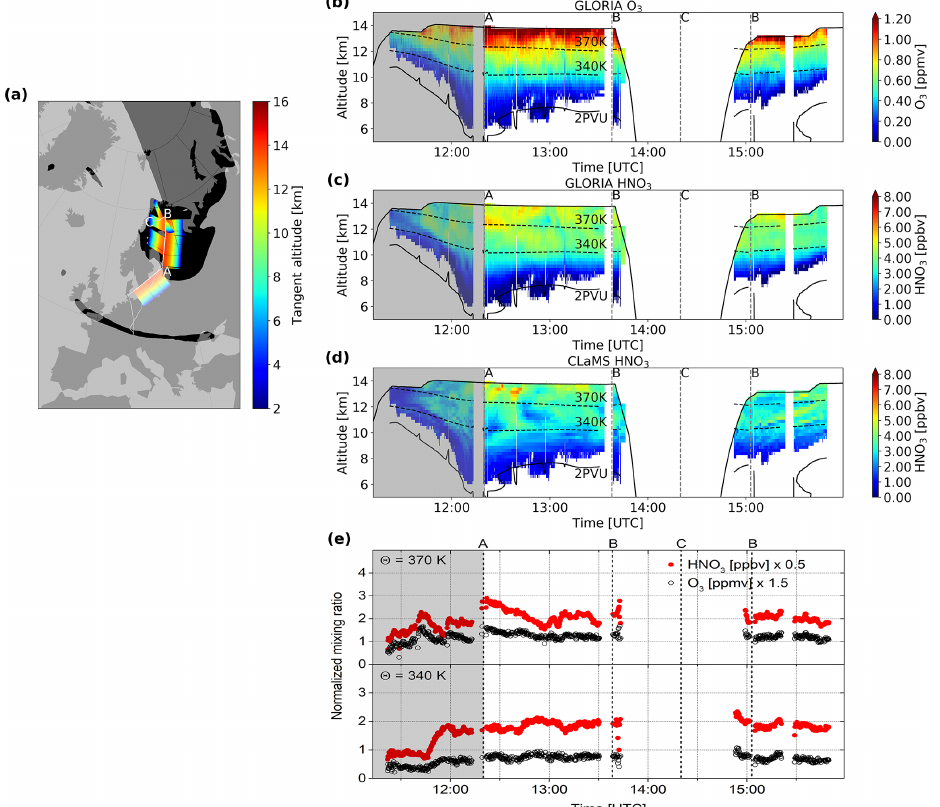
Figure 4. (a) Flight path and vortex filtering according to the Nash criterion at 370K for flight 21 on 18 March 2016. White line: flight track with characteristic waypoints (A, B, C); dark grey shading: areas that are associated with the polar vortex. Cross sections of (b) O 3 and (c) HNO 3 distribution derived from GLORIA and (d) HNO 3 distribution simulated by CLaMS for flight 21. Flight altitude (bold black line), characteristic waypoints (A, B, C), 340 and 370K potential temperature levels (MERRA-2, dashed black lines), and 2 PVU level (MERRA-2, black line). (e) Normalized HNO 3 and O 3 mixing ratios along selected isentropes. The passage attributed to non-sub-vortex air is shaded in